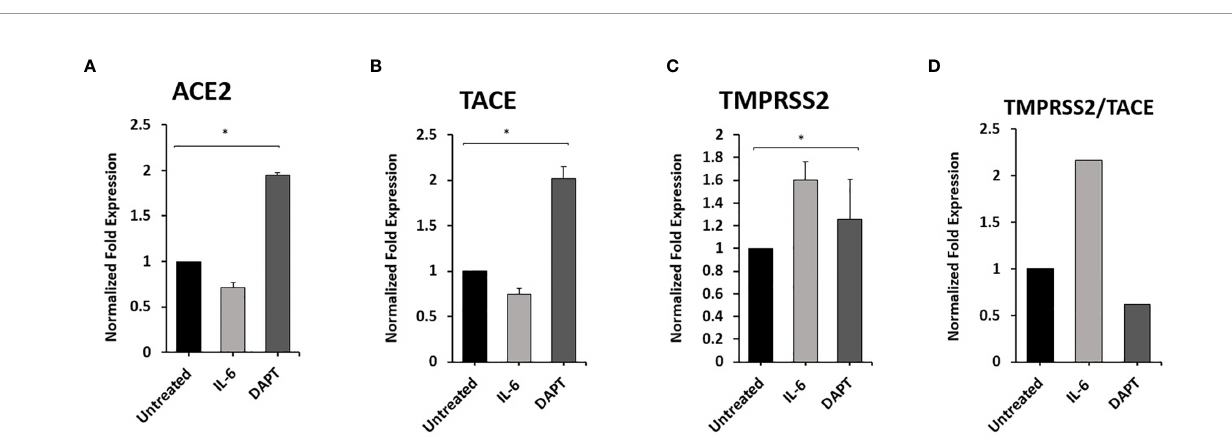
FIGURE 5 | Notch-1 and rIL-6 inhibit ACE2 and TACE expression and enhance TMPRSS2 in THP-1 derived macrophages. THP-1 derived macrophages were treated with DAPT (30 m M) and rIL-6 (500 U/ml) for 24 hours. (A – C) The expression levels of ACE2, TACE, and TMPRSS2 were detected by RT-PCR. (D) The ratio between TMPRSS2 and TACE. All experiments were performed in triplets. Data are shown as mean ± SD, and signi fi cance is considered as *P <